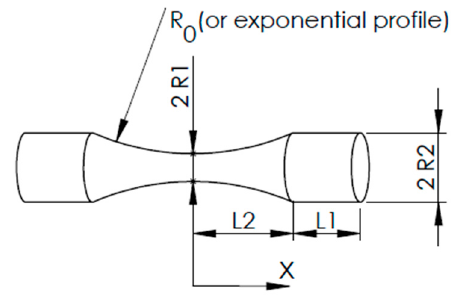
Figure 2. UHCF specimen coordinate system and main dimensions, adapted from [1].